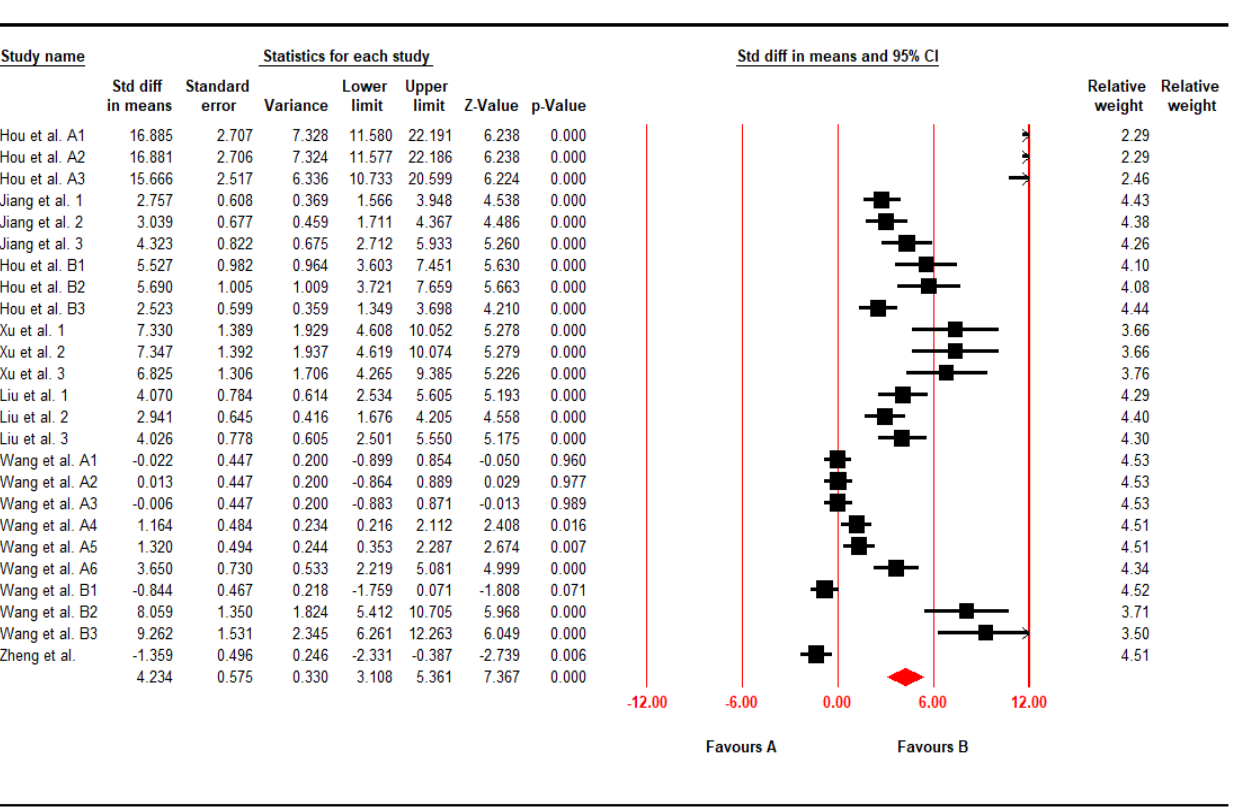
Figure 4. Forest plot of Elevating Serum GSH-Px (SMD, 4.23; 95% CI, 3.10 to 5.36; p < 0.001; I 2 = 93.69%). Black solid square indicated the individual study’s SMD and the red solid square indicated the polling SMD of the included studies.